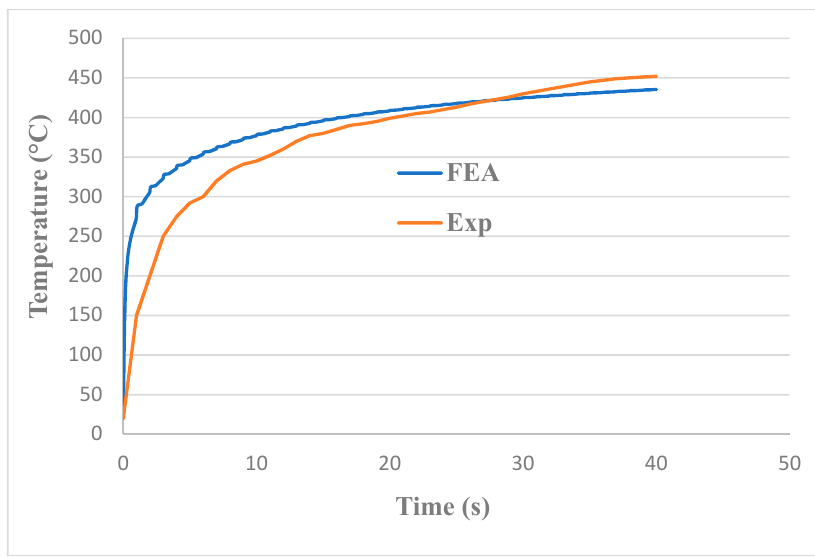
Figure 6. Comparison between finite element analysis and experimental results.